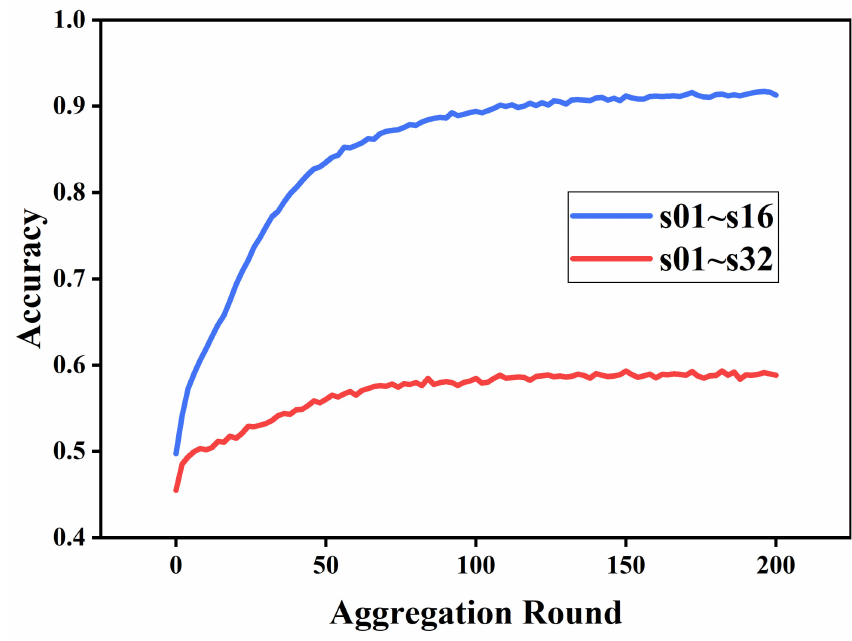
Figure 5. The accuracy of training under s01~s16 DEAP data, using the test set composed of s01~s16 data and the test set composed of